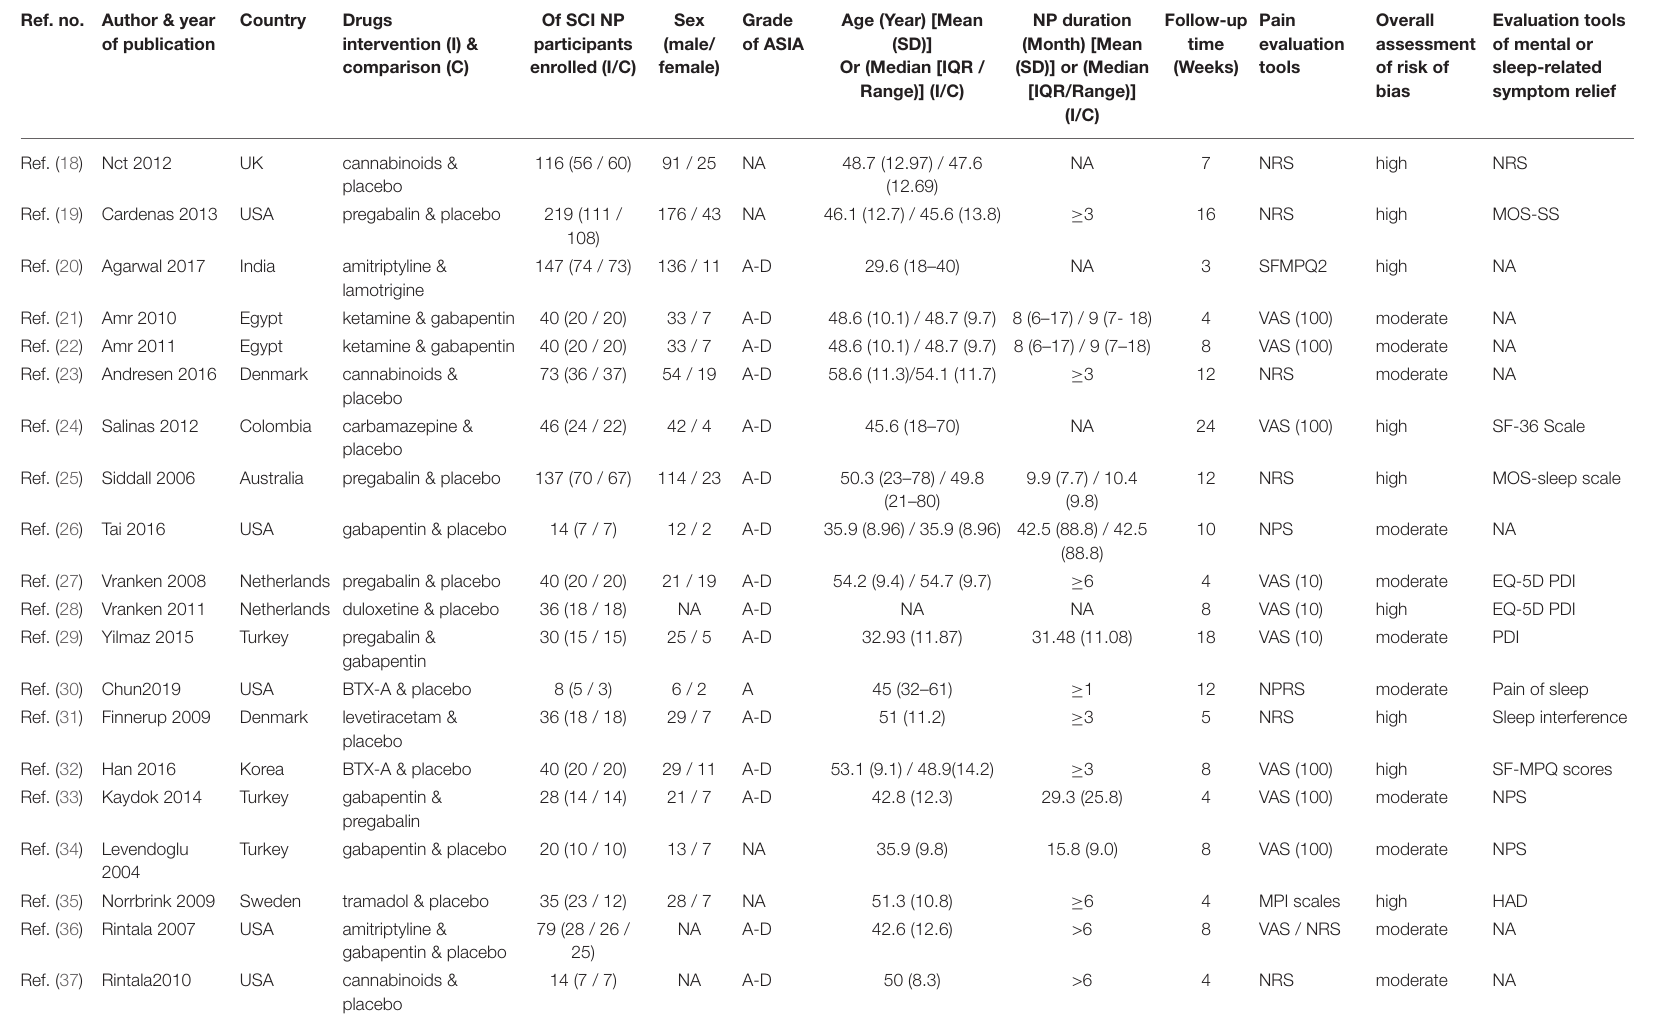
TABLE 1 | Baseline characteristics of included